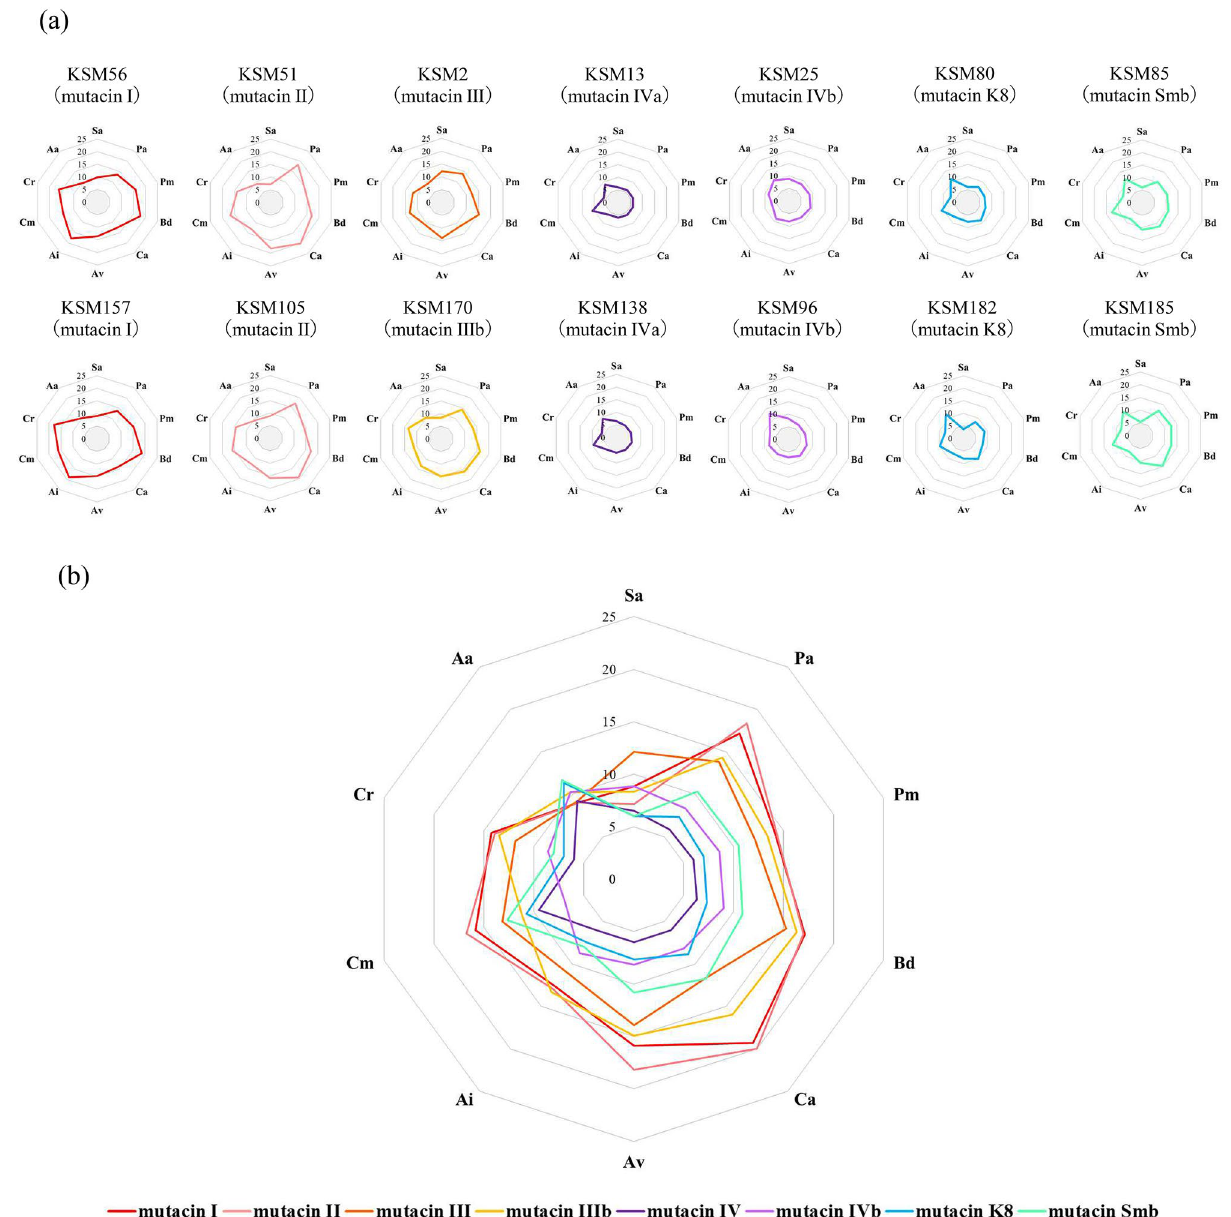
Figure 4. Antibacterial activity of each bacteriocin gene single-positive strain against 10 oral bacterial species. To evaluate the antibacterial activity of bacteriocins, a direct assay was performed with the method described in the Materials and methods section. ( a ) Two single-positive strains for each bacteriocin except mutacin III and mutacin IIIb were selected. ( b ) Merged antibacterial activity of each single positive strain (KSM2, 13, 25, 56, 51, 80, 85, 170). Three independent experiments were performed, and the average diameter was calculated. The number in each panel represents the diameter of the inhibition zone (mm). Sa: S. aureus, Pa: P. anaerobius,